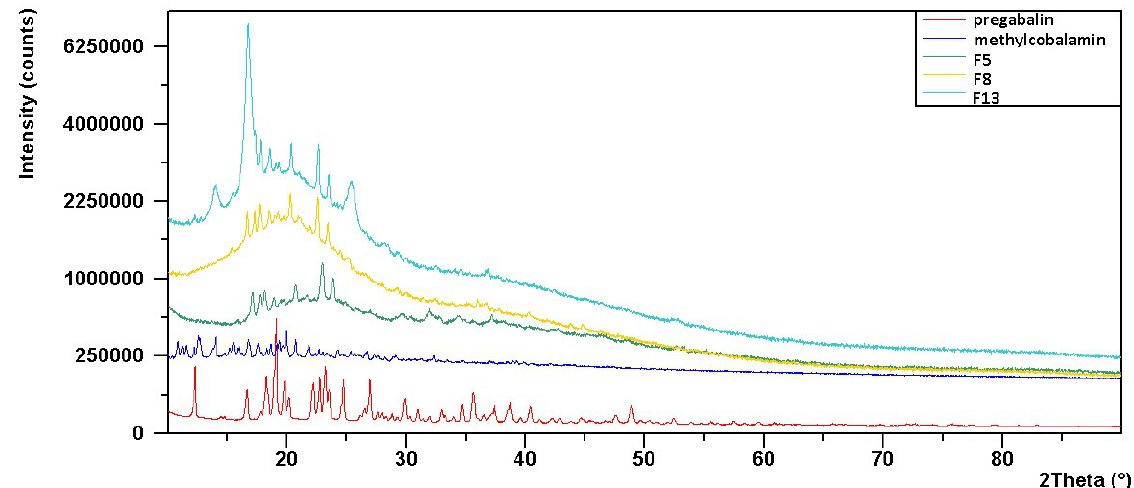
Figure 6. XRD diagrams of PG, MC, and optimum formulations .